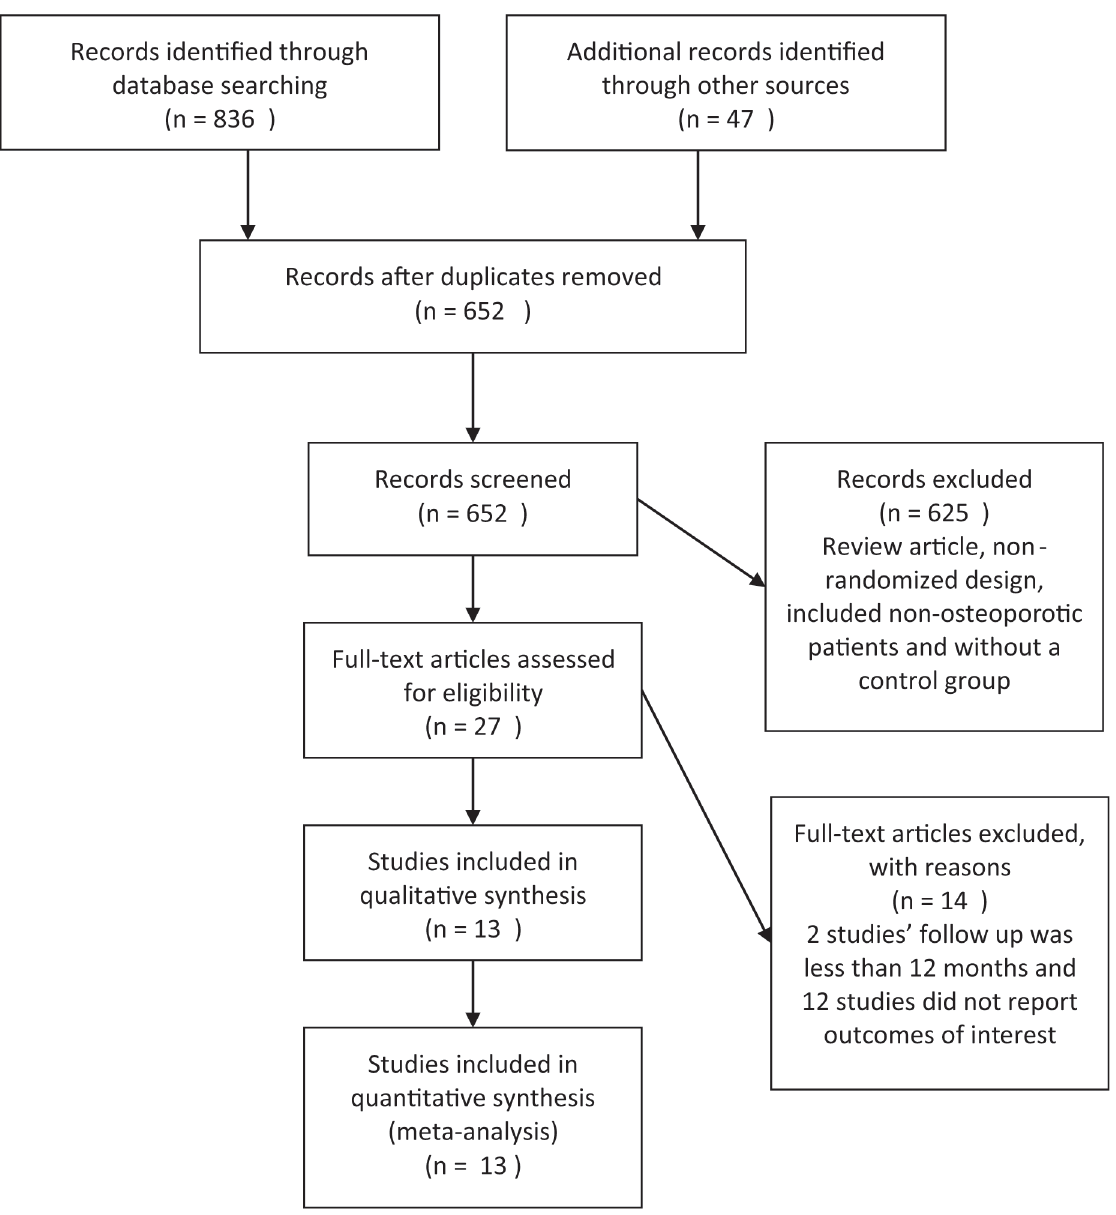
Fig 1. PRISMA flow